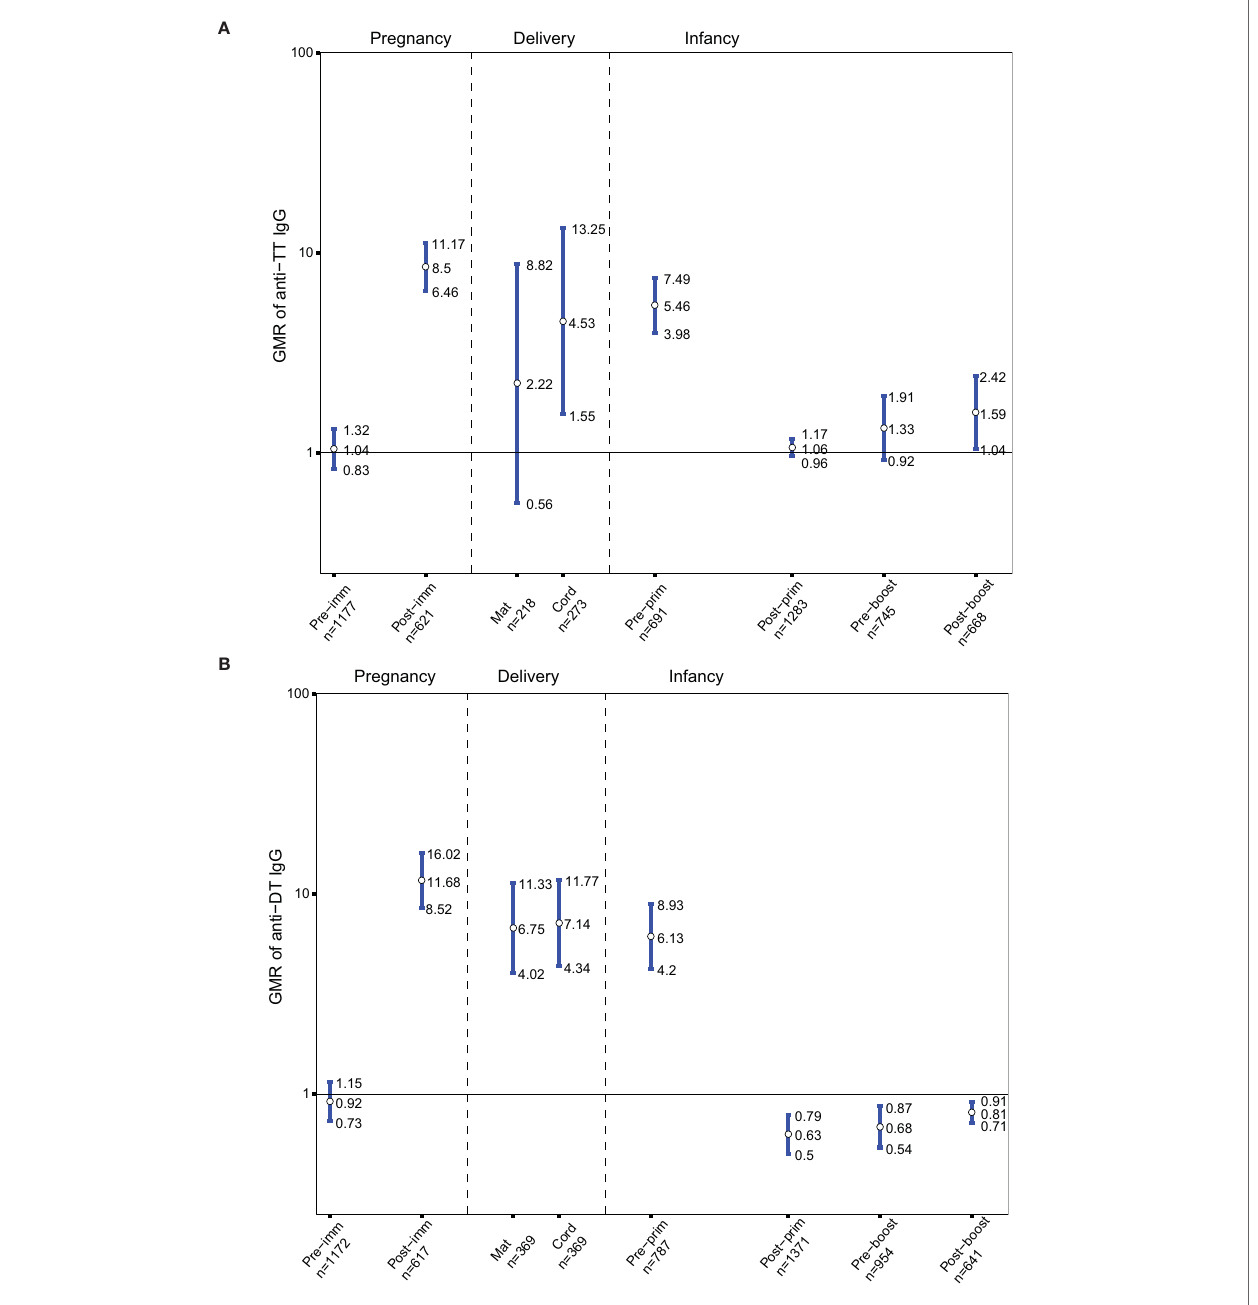
FIGURE 3 | (A) Antibody responses to tetanus-toxoid (TT). Geometric mean ratio (GMR) of anti-TT IgG levels in women immunized with tetanus-diphtheria- acellular-pertussis (Tdap) versus women who did not receive Tdap or diphtheria and tetanus toxoids (dT) or TT vaccine in pregnancy pre-immunization, post- immunization and at delivery; in infants born to women immunized Tdap versus infants of women not immunized with Tdap dT, or TT vaccine in pregnancy pre- primary, post-primary, pre-booster and post-booster immunization with diphtheria-tetanus-acellular-pertussis vaccine. (B) Antibody responses to diphtheria- toxoid (DT). GMR of anti-DT IgG levels in women immunized with Tdap versus women who did not receive Tdap or dT vaccine in pregnancy pre-immunization, post-immunization and at delivery; in infants born to women immunized Tdap versus infants of women not immunized with Tdap or dT vaccine in pregnancy pre-primary, post-primary, pre-booster and post-booster immunization with diphtheria-tetanus-acellular-pertussis vaccine. Vertical blue lines indicate the GMR with the 95% con fi dence interval. Horizontal black line indicates a GMR of 1. The numbers available for meta-analysis are indicated (n). GMR results displayed are derived from mixed-effects models. Pre-imm, pre-immunization; Post-imm, post-immunization; Mat, maternal; Pre-prim, pre-primary; Post-prim, post- primary; Pre-boost, pre-booster; Post-boost,